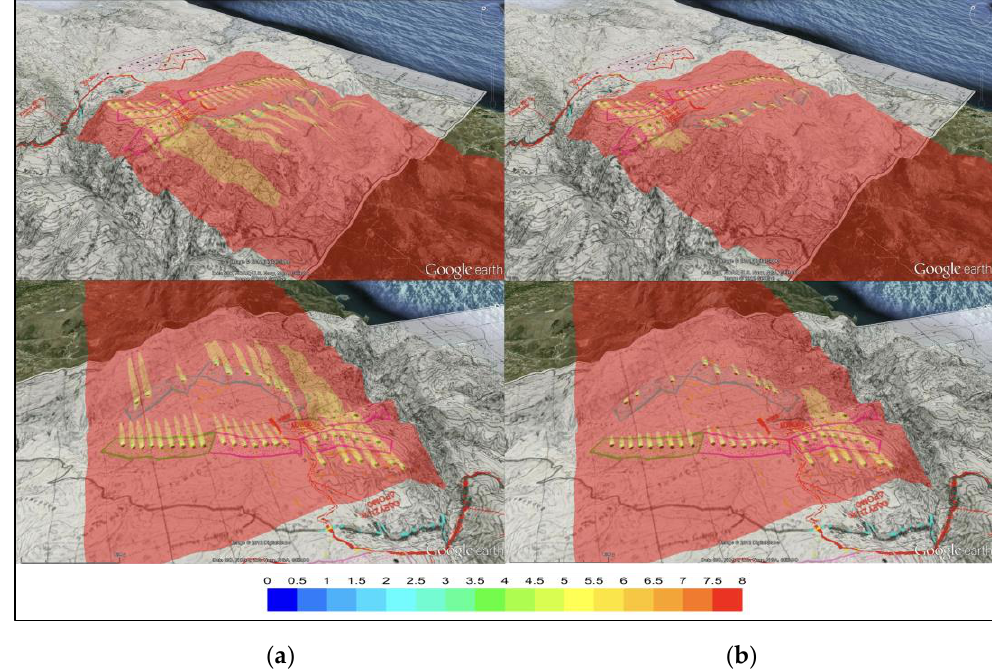
Figure 9. Velocity deficit ( m s⁄ ) at HUB height, projected on the complex topography of Chios island. ( a ) 𝑇𝐼 = 8% . ( b ) 𝑇𝐼 = 15% .